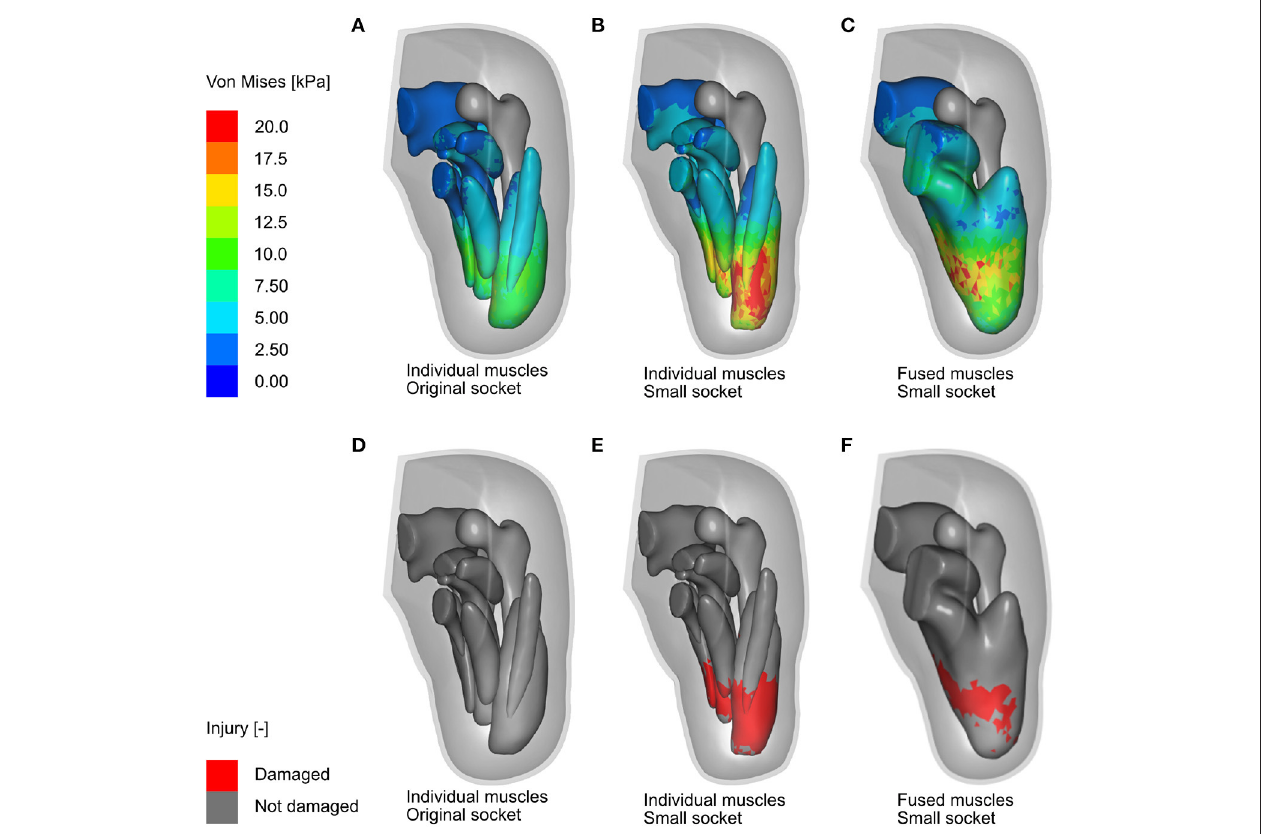
FIGURE 11 | FE analysis of bipedal stance. Shown here are the results of the FE analysis (in the anterior-medial viewing direction) for the three cases discussed above. (A,B) Show the Von Mises stresses in the residual limb muscles after the 2-h bipedal stance, when analysing the individual-muscle model of the residual limb with the original and misfitted sockets, respectively, while (D,E) Show damage in the skeletal muscles in the same period. (C,F) Show the Von Mises stresses and soft tissue damage, respectively, in the fused-muscle model of the residual limb. The stress legend is common for all three cases and was capped at 20 kPa for better illustrating the stress